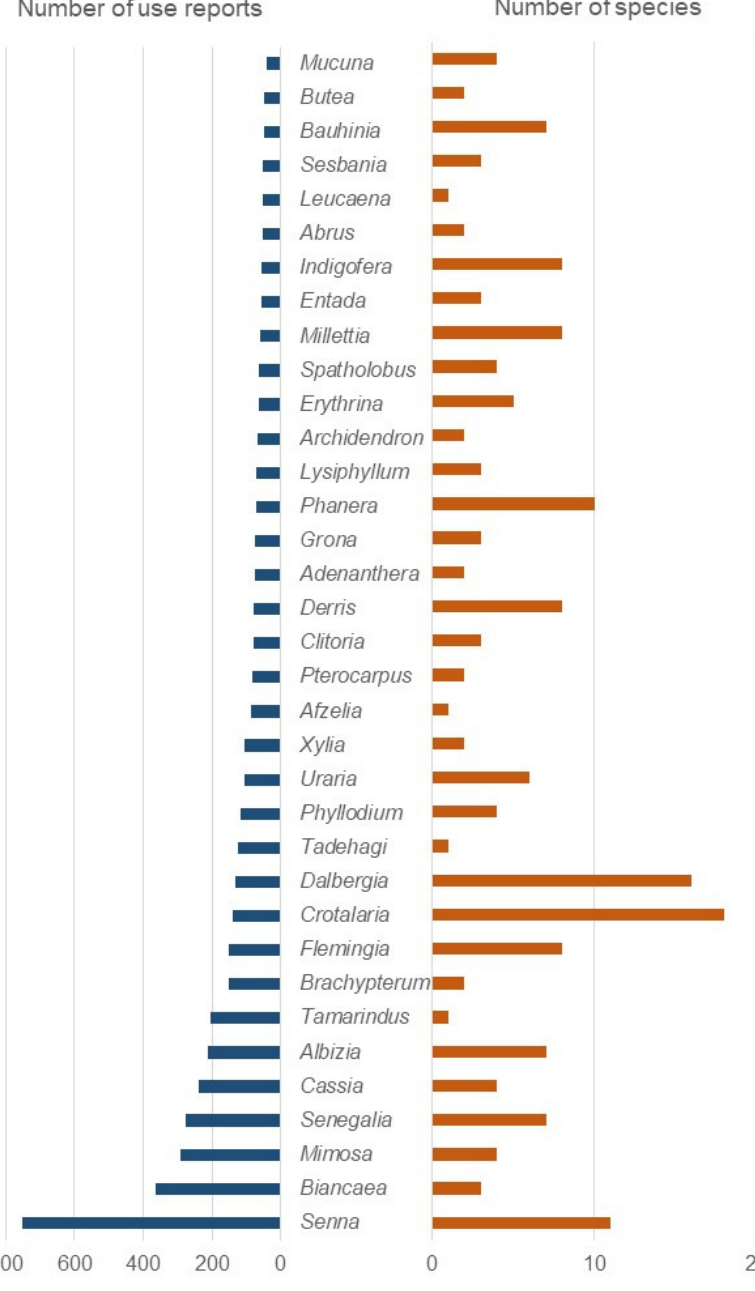
Figure 1. Numbers of species and use reports for legume genera with medicinal uses in Thailand, derived from 152 primary data sources published from 1986–2019.